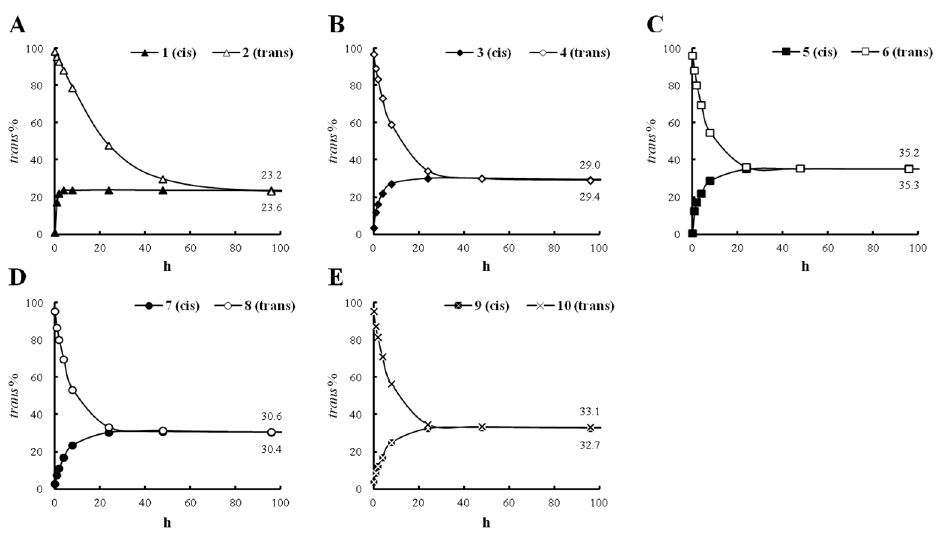
Figure 3. Conversion rates and stabilized ratios of compounds 1 and 2 ( A ); compound 3 and 4 ( B ); compound 5 and 6 ( C ); compound 7 and 8 ( D ); compound 9 and 10 ( E